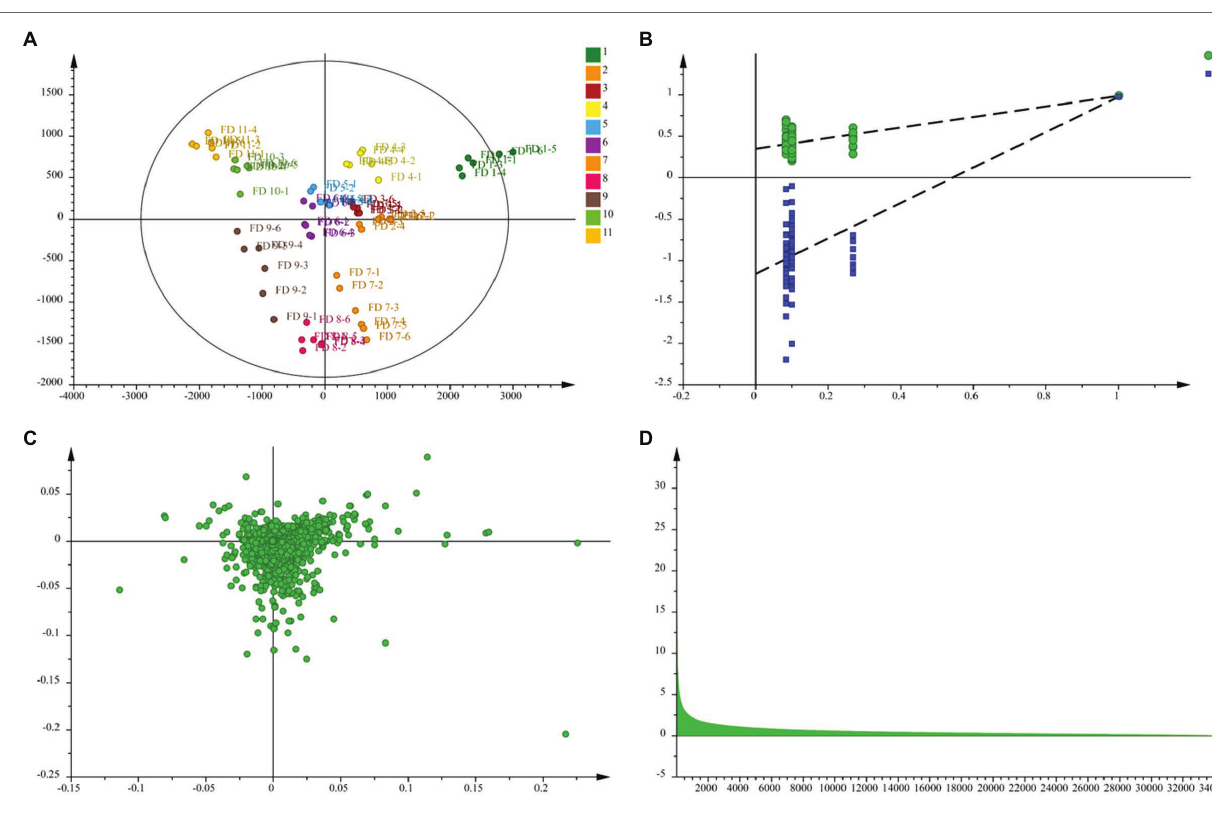
FIGURE 7 | Partial least squares discriminant analysis (A) , permutation test (B) , loading plot (C) , and variable importance in the projection (VIP; D ) in negative ion